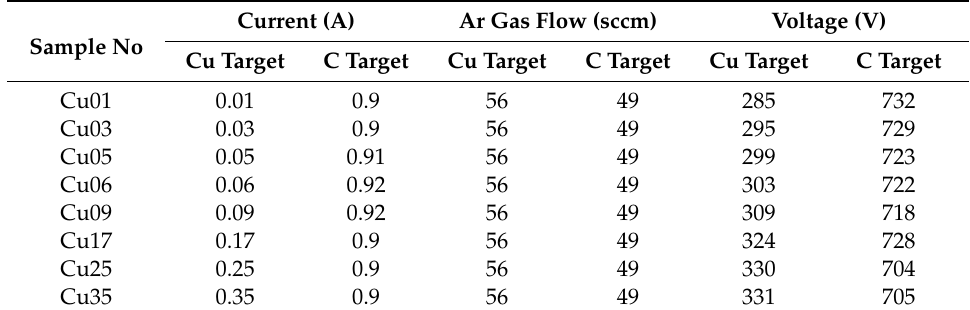
Table 1. Numbering of the samples and other deposition conditions used in magnetron sputtering deposition of DLC:Cu